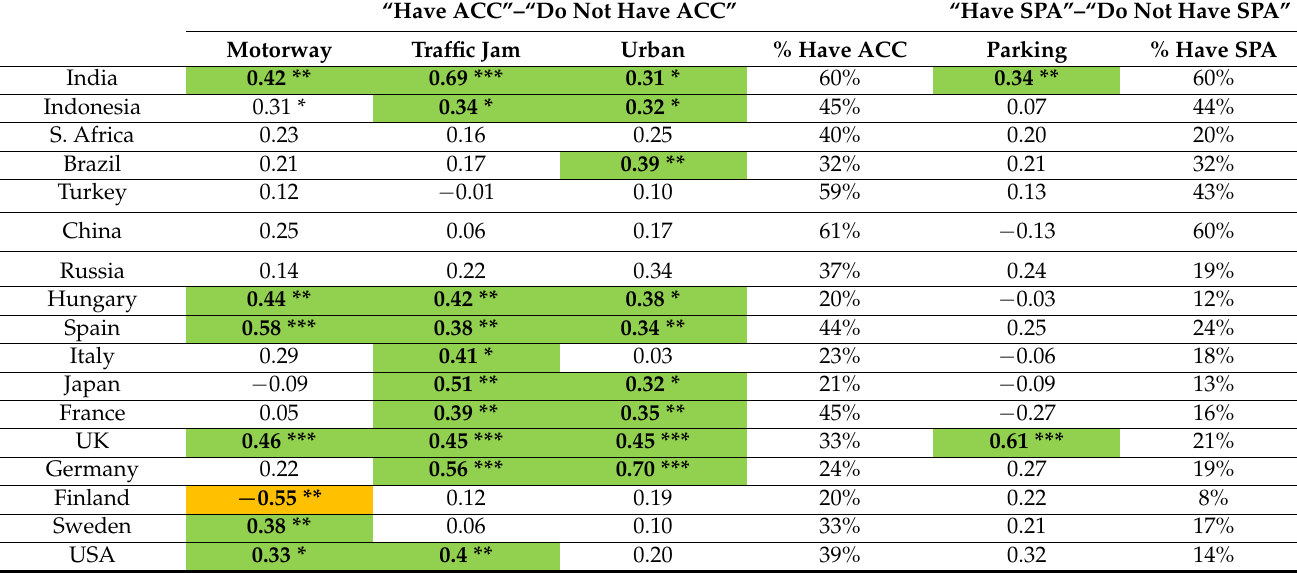
Table 10. Differences in the mean intention to use scores across countries (ordered from lowest to highest GDP; [33]) and for different ADFs between drivers who do and do not have ADAS (Self-Park Assist; SPA) for the Parking ADF and Adaptive Cruise Control (ACC) for all other ADFs. A positive number highlighted green indicates that males had a significantly higher intention to use score than females. A negative number highlighted orange indicates that females had a significantly higher intention to use score than males. “Have ACC”–“Do Not Have ACC” “Have SPA”–“Do Not Have SPA” Motorway Traffic Jam Urban Parking % Have